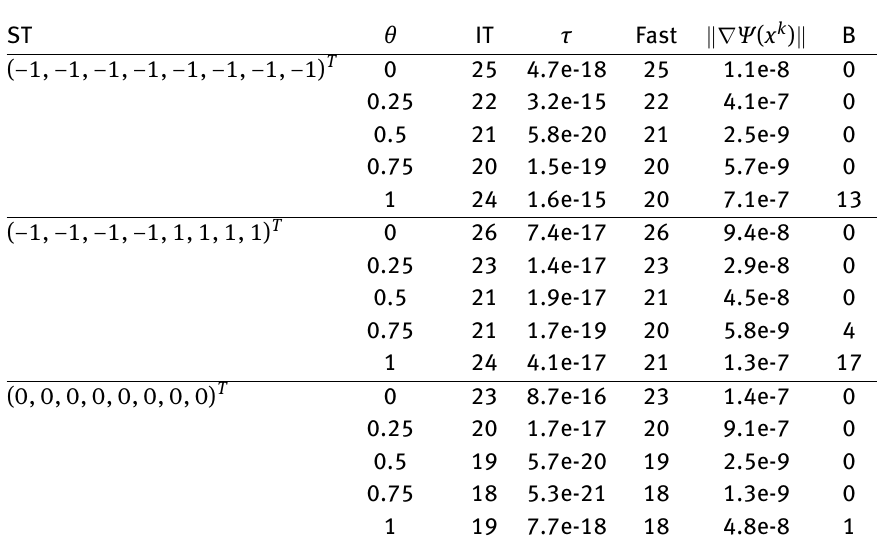
Table 3: Numerical behavior for Example 5.3